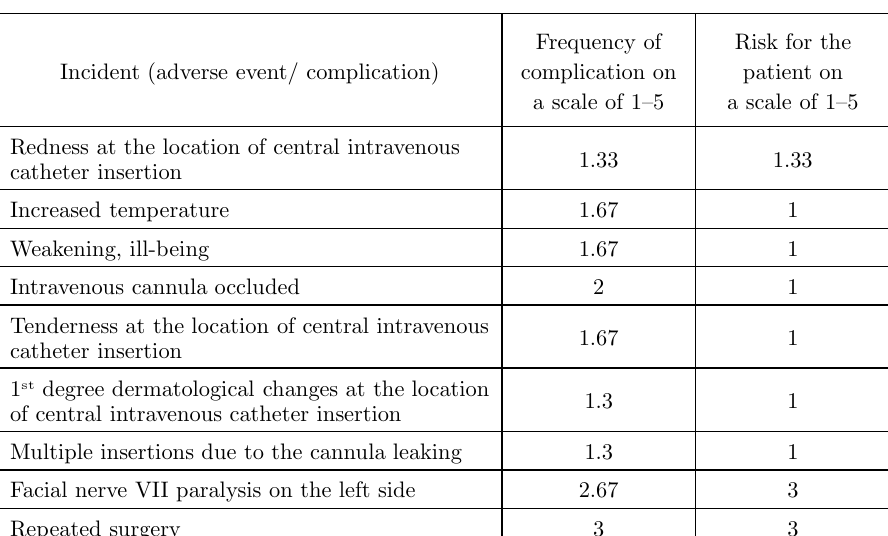
Table 7. Expert assessment for complications occurring during C22 settlement group